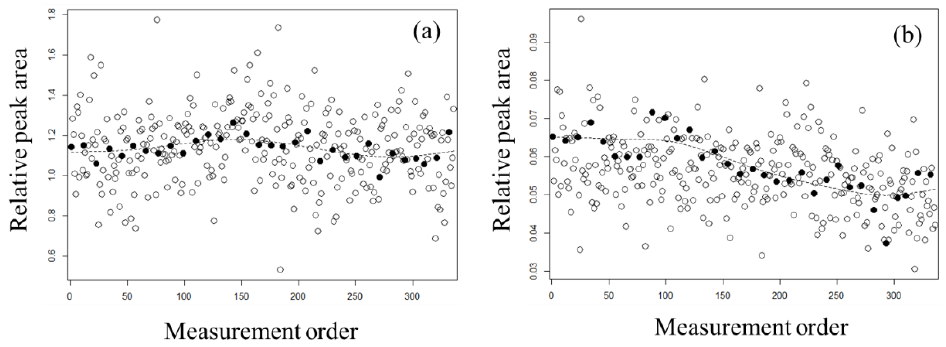
Figure 2. The smoothing trends for ( a ) carnitine and ( b ) uridine. Open circles indicate each individual’s actual samples and closed circles indicate QC samples. The dashed lines show estimated values of normalization using the QC samples with Whittaker smoothing.